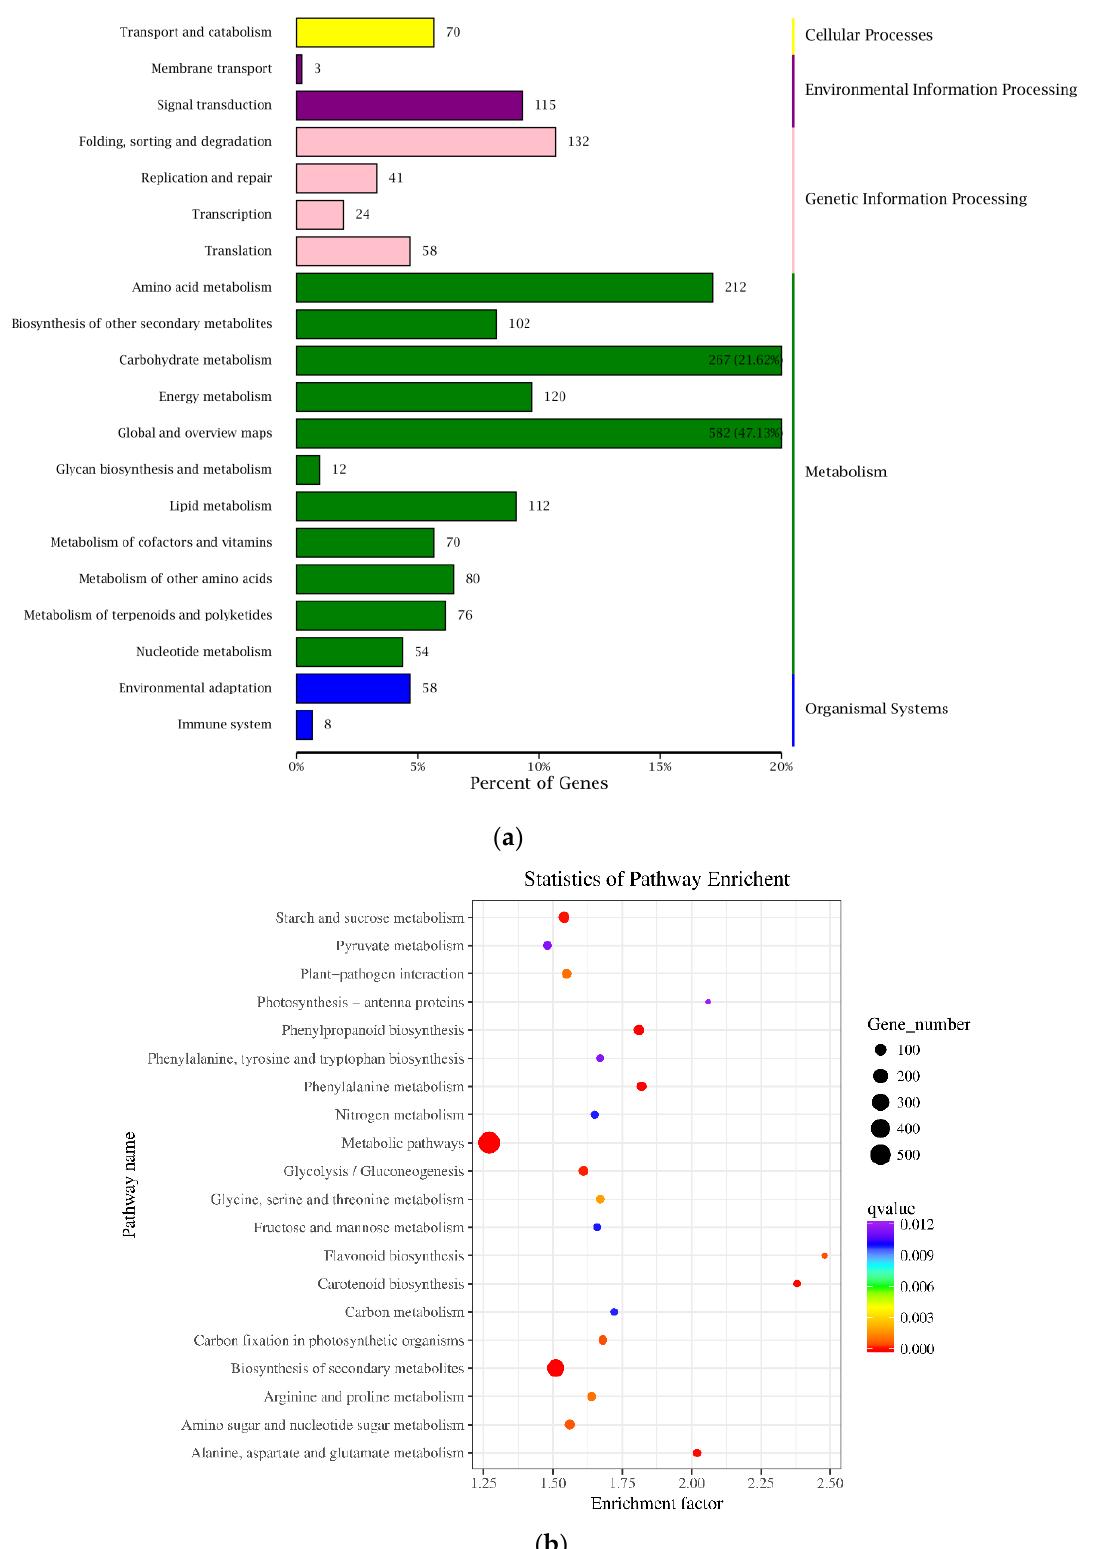
Figure 5. KEGG pathway enrichment analysis. ( a ) Statistic analysis of annotated genes in KEEG pathways, ( b ) scatterplot of KEEG pathway enrichment for DEGs.